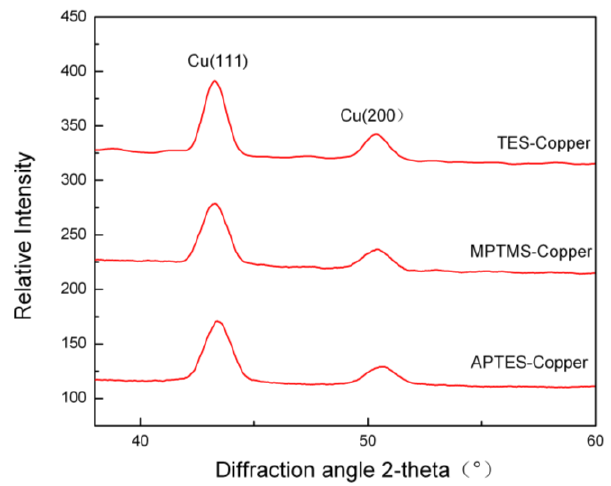
Figure 6. XRD patterns of copper film on different SAMs modified ABS